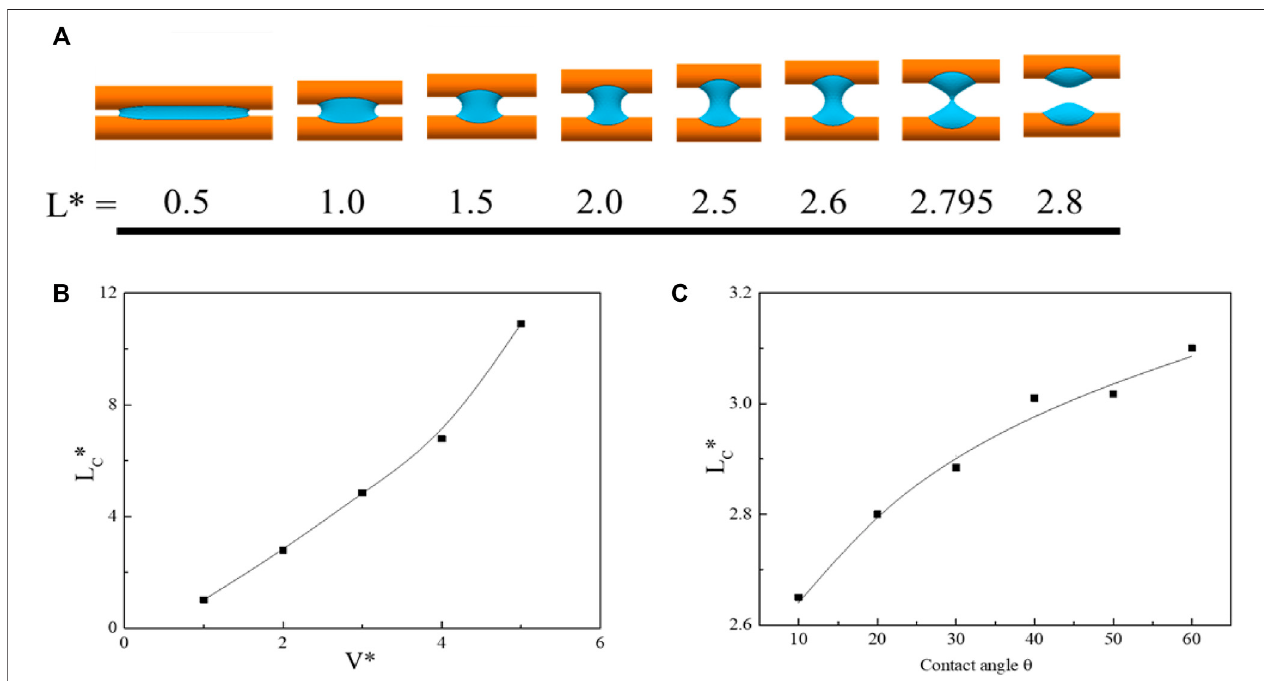
FIGURE 4 | (A) Evolution of liquid bridge with fi ber spacing from simulation in the parallel fi bers. (B) Variation of the dimensionless critical spacing with the V*. (C) Variation of the dimensionless critical spacing with the contact angle.